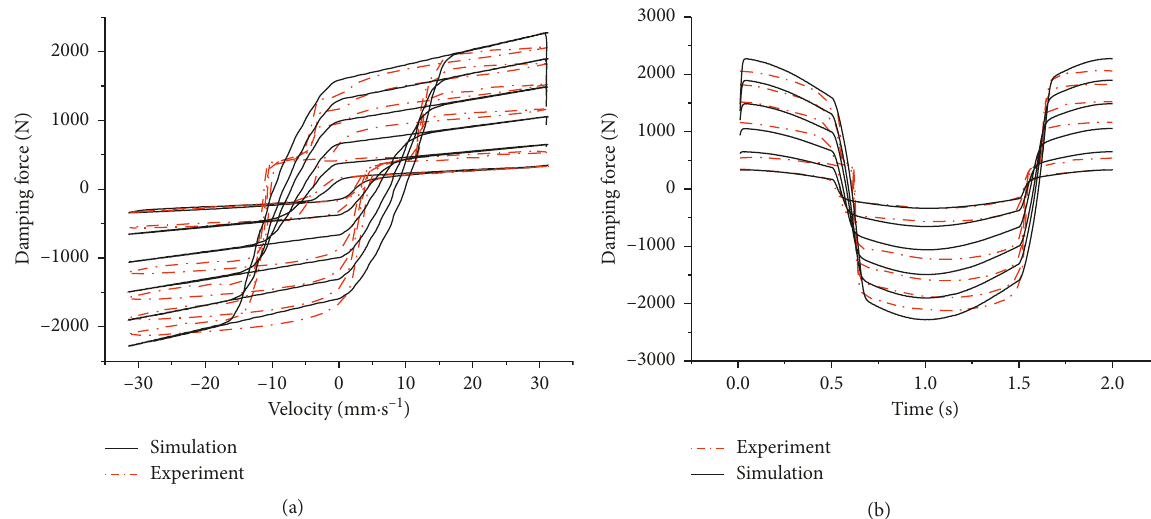
Figure 12: Comparison of simulation results and experimental data at 10 mm and 0.5Hz: (a) velocity vs. damping force; (b) time vs. damping force.